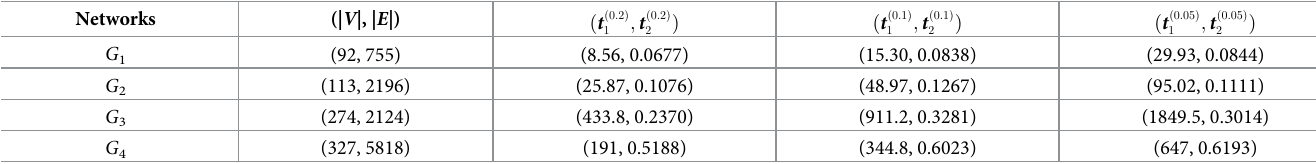
The graphs G 1 , G 2 , G 3 and G 4 correspond to ‘ia-workplace-contacts’, ‘ia-contacts_hypertext2009’, ‘ia-contact’ and ‘contacts-prox-high-school-2013’, respectively. We use ð t ð p Þ ; t ð p Þ Þ to indicate a pair of times in seconds for computing MIT matrix by 100 simulations/samplings with Algorithms 1 and 2 respectively, where p is the infection 1 2